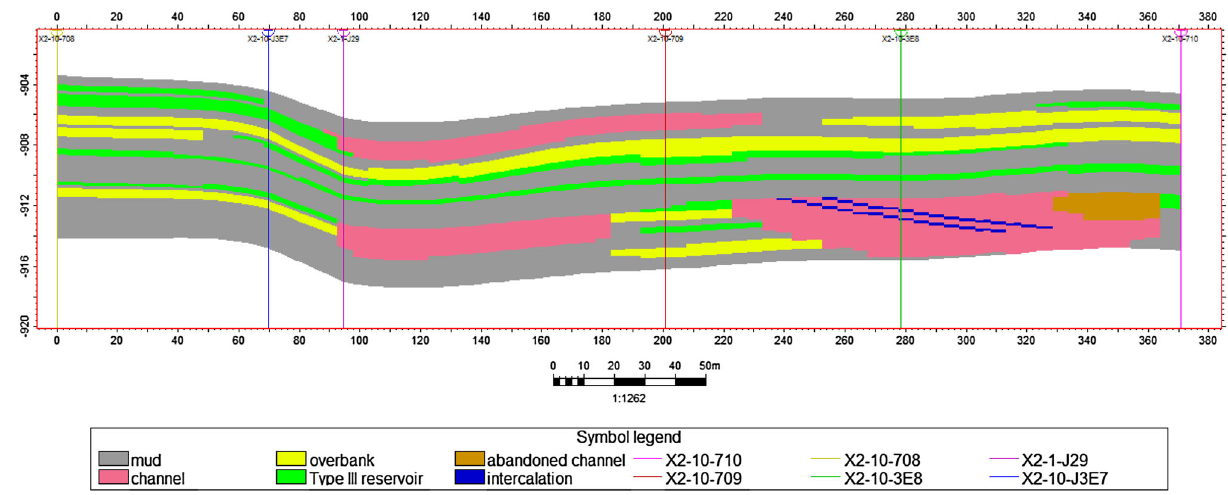
Fig. 7 Reservoir architecture model of the S2 layer set of profile A in the study area